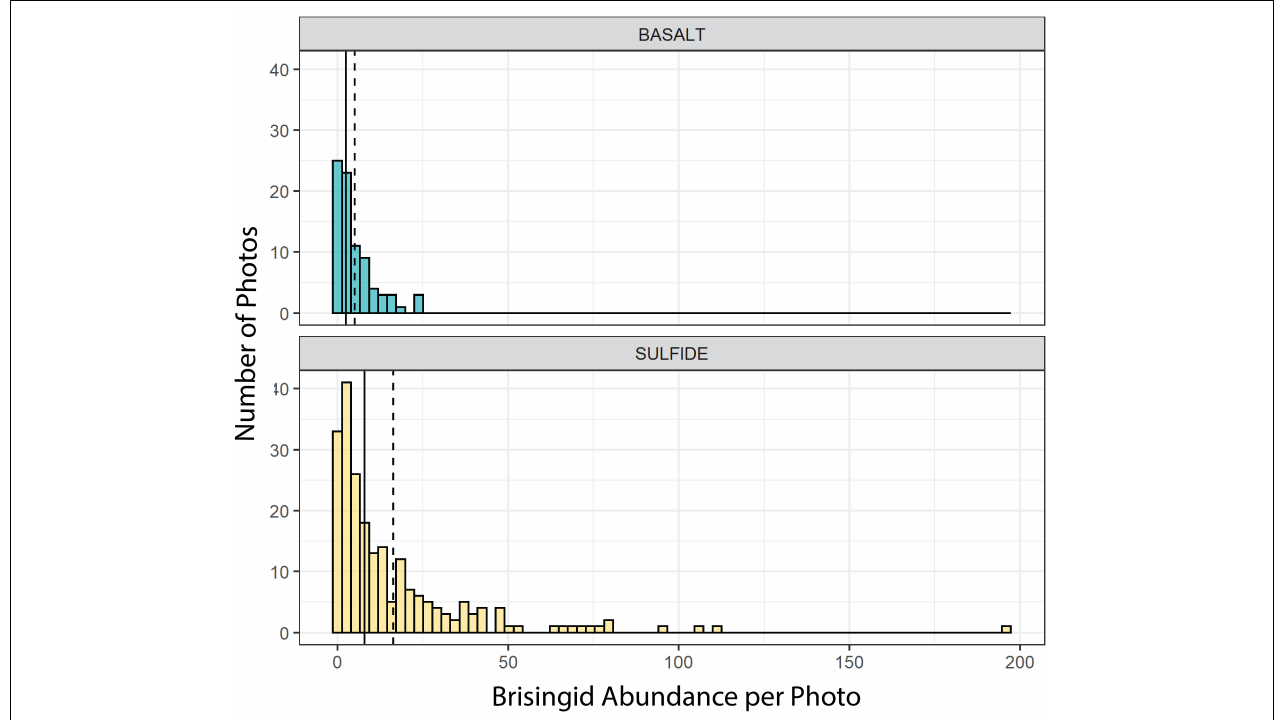
FIGURE 5 | Frequency distributions of brisingid abundances per photo on basalt and hydrothermally inactive sulfide substrata. Solid lines: median; dashed lines: mean.